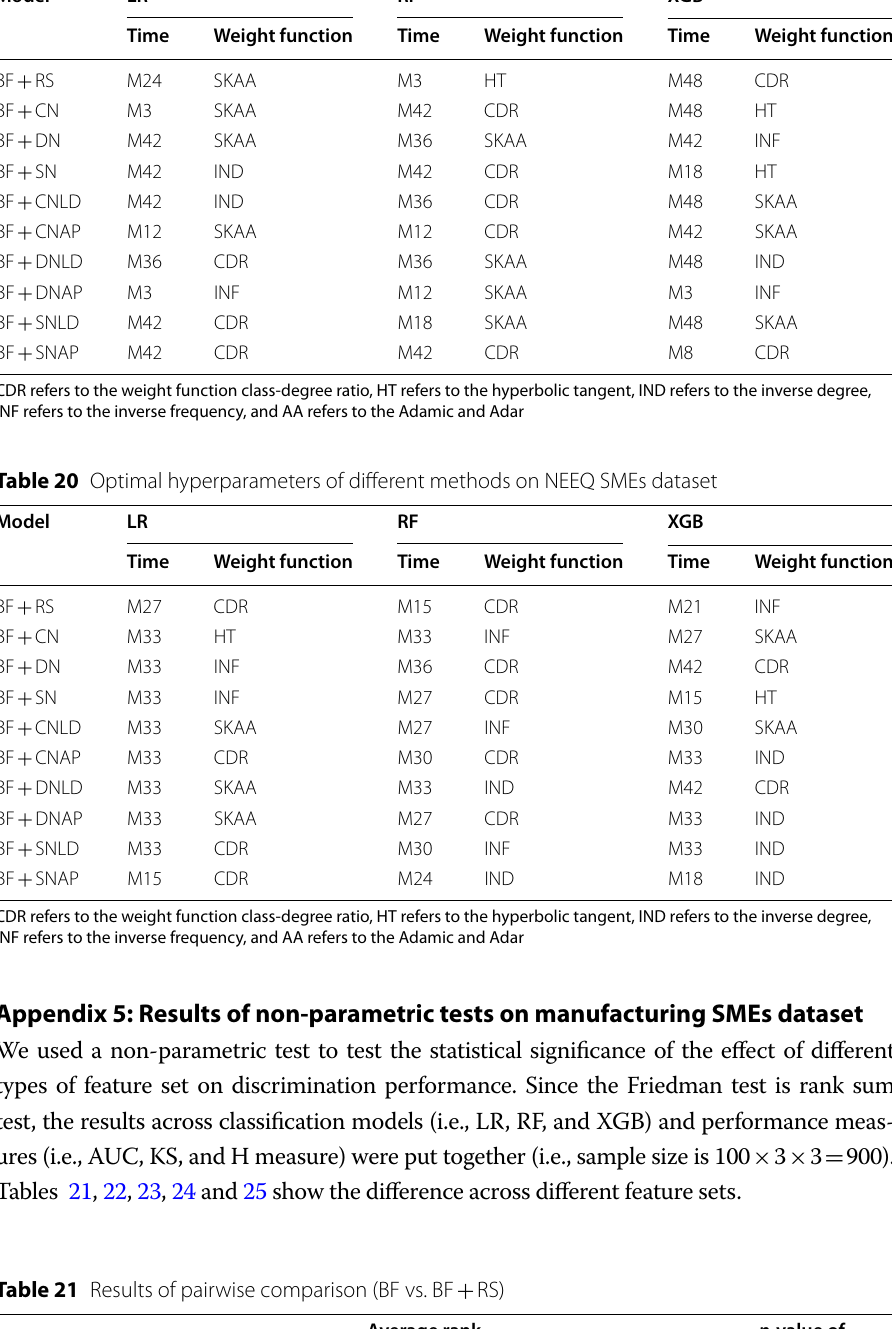
Table 19 Optimal hyperparameters of different methods on manufacturing SMEs dataset Model